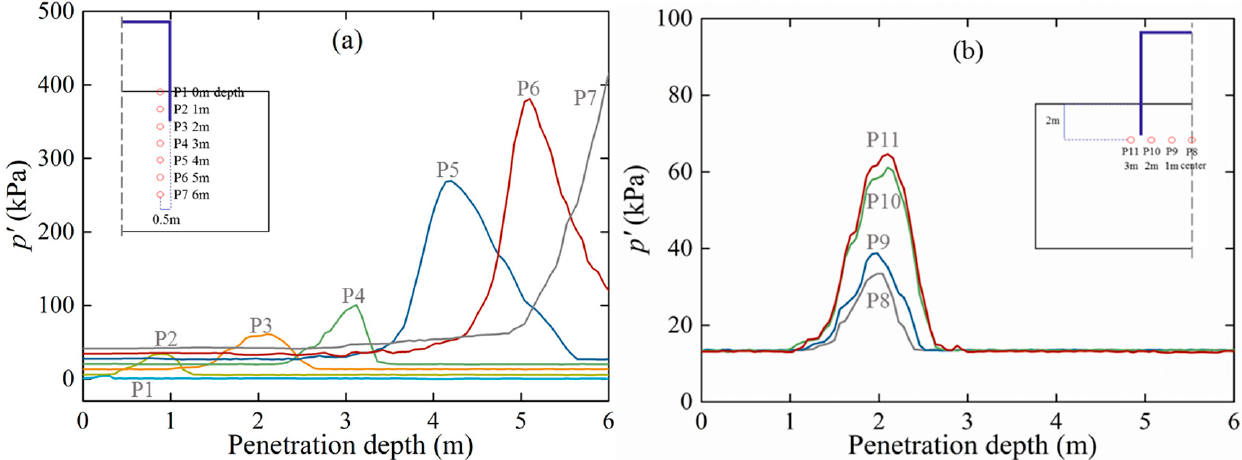
Figure 7. Mean effective stress evolution with caisson jacked penetration depth at typical points within the soil: ( a ) Points P1 to P7; ( b ) Points P8 to P11.